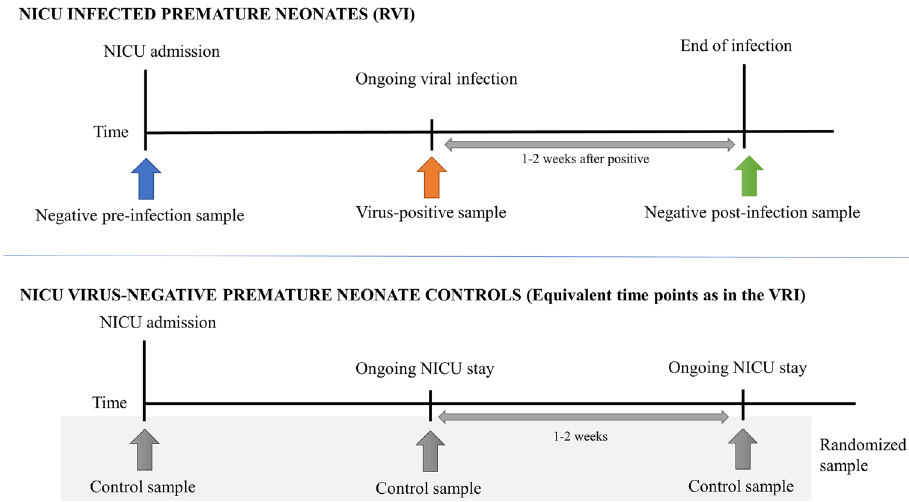
Figure 1. Graphical representation of the study design, representing how sampling was performed for both the NICU infected premature infants and the NICU virus-negative premature infants (control